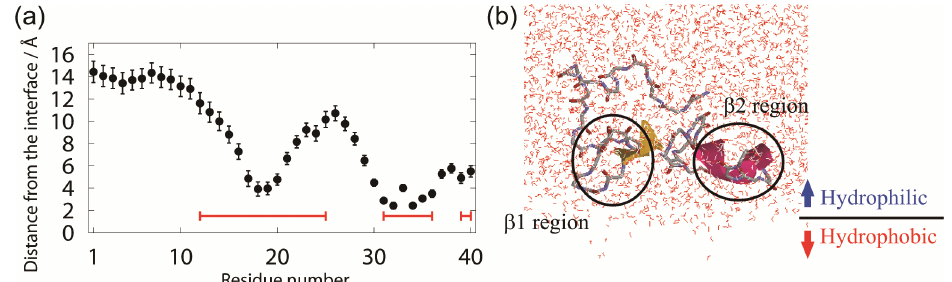
Figure 5. ( a ) Average distance of each C α atom of the A β peptide from the interface. Red lines show the residues that bound to the lyso-GM1 micelle in the experiments [93]. ( b ) A typical snapshot of the A β 40 peptide at the interface. Reprinted with permission from Reference [25]. Copyright 2019 American Chemical Society.